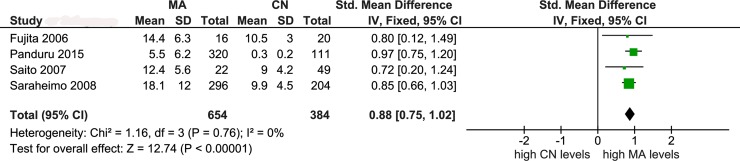
Forest plot of post-outlier control versus macroalbuminuria comparison.LEGEND: MA: macroalbuminuria; CN: control; SD: standard deviation; CI: confidence interval; df: degree of freedom.